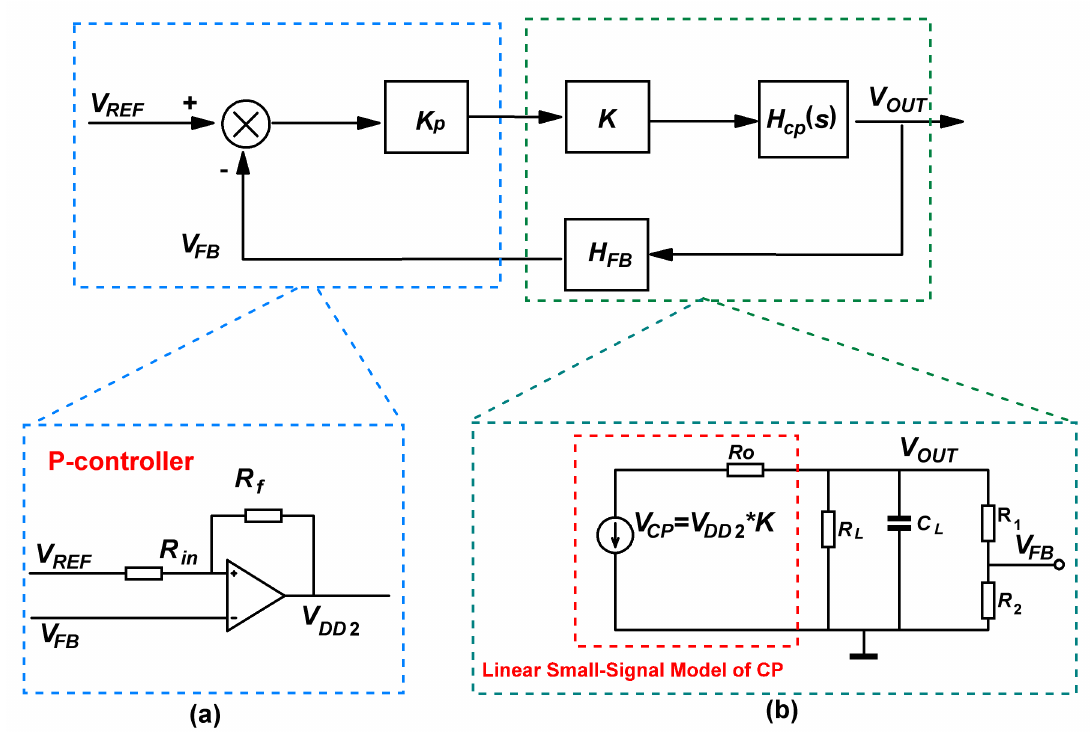
Figure 5. Block diagram of the closed-loop model. ( a ) P-controller, ( b ) linearized charge pump small-signal